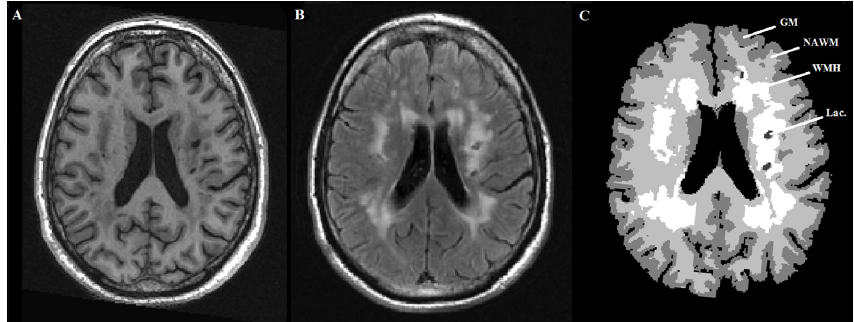
Fig 2. A. T1-weighted image B. FLAIR image C. Corresponding tissue segmentation map. Abbreviations: GM = grey matter; NAWM = normal appearing white matter; Lac. = lacune of presumed vascular origin; WMH = white matter hyperintensity.